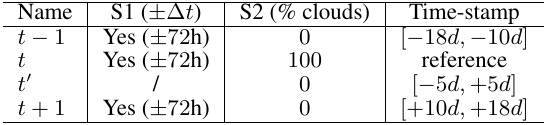
Table 6. Acquisitions layout enabling the comparison of the gapfilling and the MSOP unet network. The cloud coverage at t is 100% , all other optical images remain cloud free.